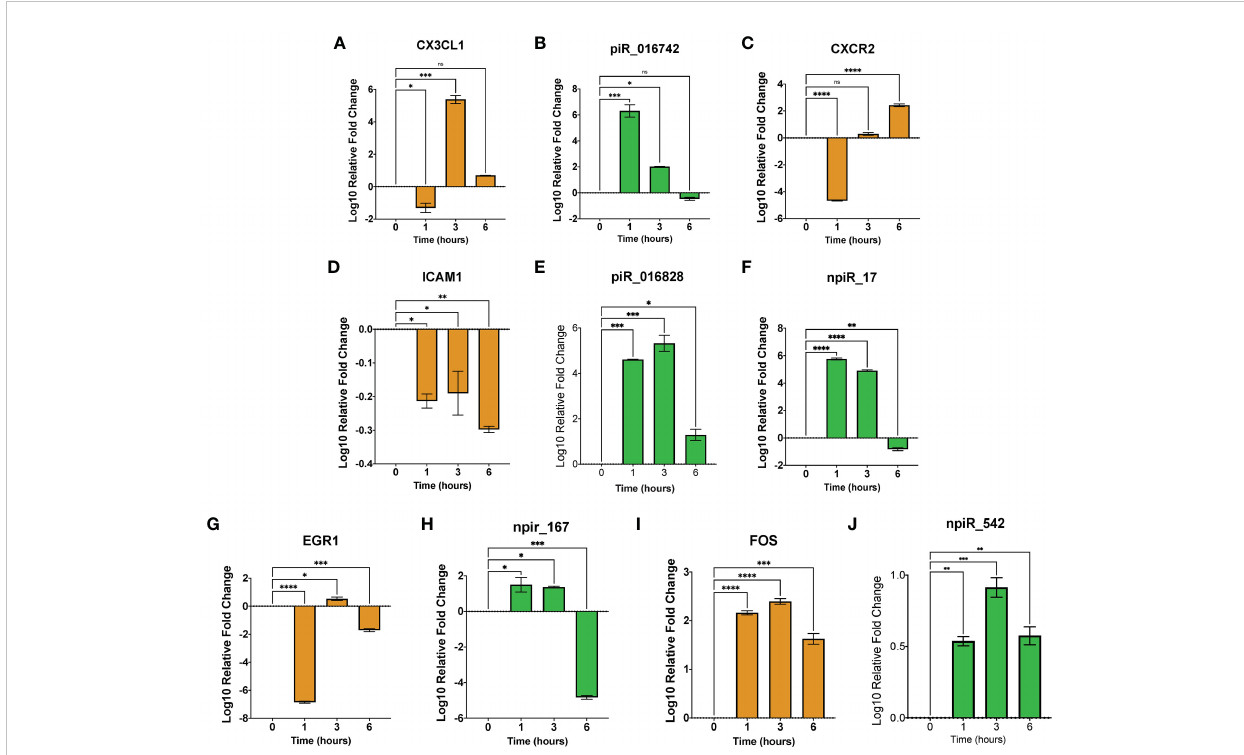
FIGURE 4 Early T. cruzi infection dysregulates expression of piRNAs and their targets. (A – J) . Total RNA and small RNA were puri fi ed from PHCF challenge with invasive T. cruzi trypomastigotes. Target transcript expression was evaluated using RT-qPCR, while piRNA expression was validated using stem-loop PCR for cDNA synthesis and RT-qPCR for relative expression. Bar graphs show log 10 fold change ± SEM (n=3). Orange bar graphs denote relative mRNA target transcript expression while green bar graphs represent relative piRNA expression. Student ’ s t-test and visualization performed using